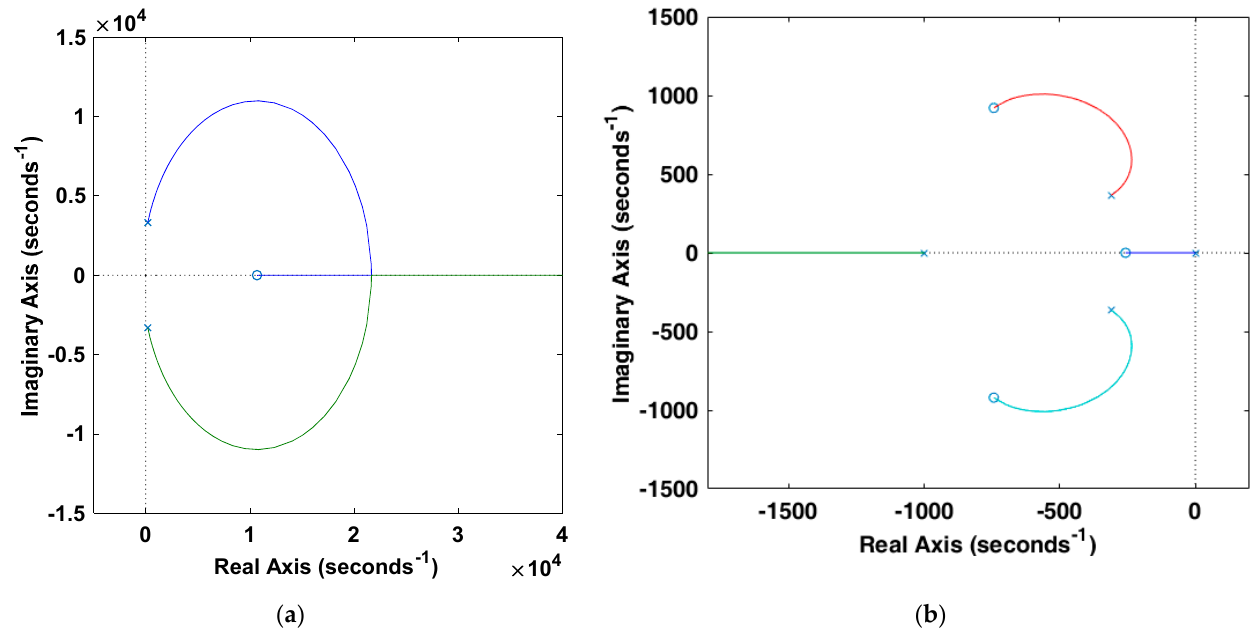
Figure 3. Root locus of the ( a ) uncompensated system; ( b ) compensated system.